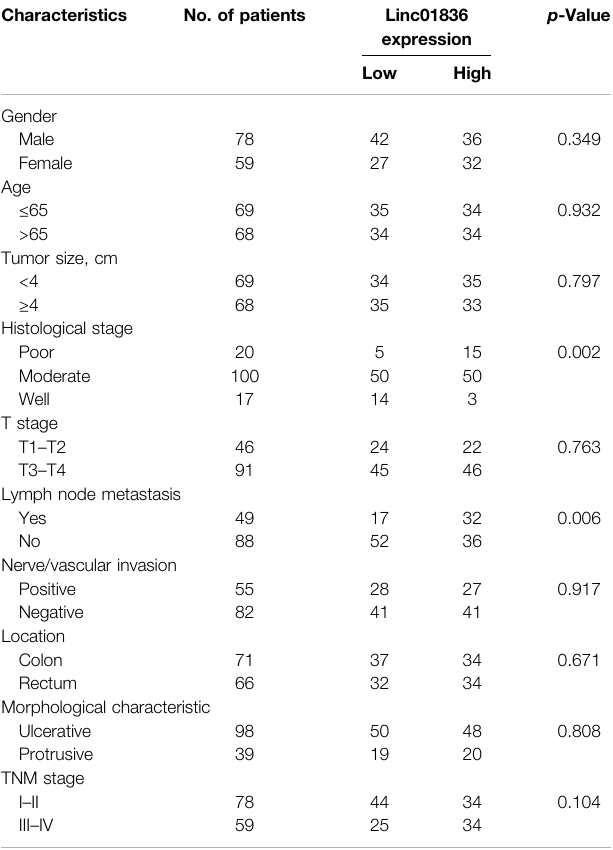
TABLE 4 | Correlation between Linc01836 expression and clinicopathologic parameters of colorectal cancer (CRC) patients.